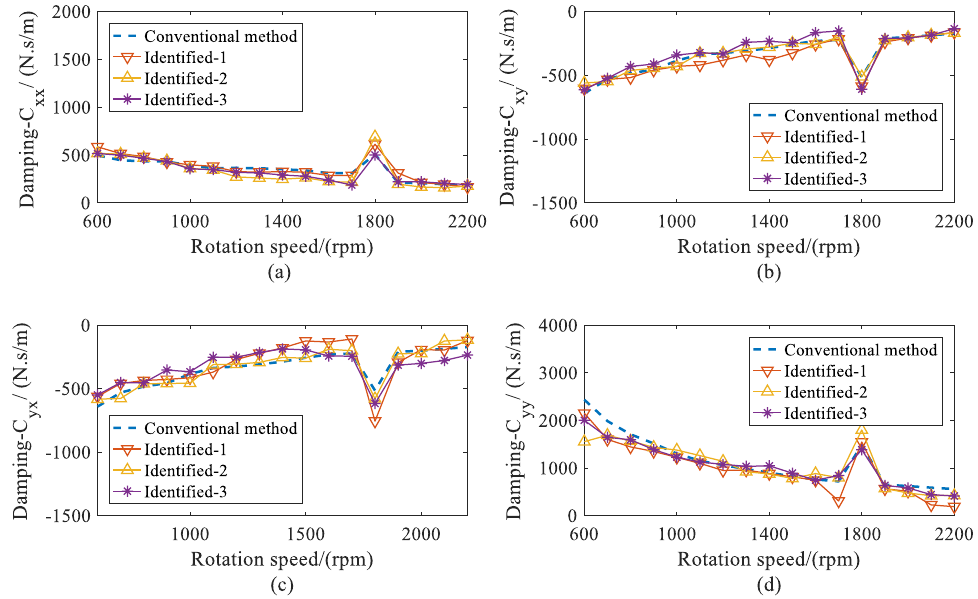
Figure 15. Comparison for damping coefficients of bearing 2 versus rotor speed; ( a ) direct damping coefficients C xx ; ( b ) cross-coupled damping coefficients C xy ; ( c ) cross-coupled damping coefficients C yx ; ( d ) direct damping coefficients C yy .